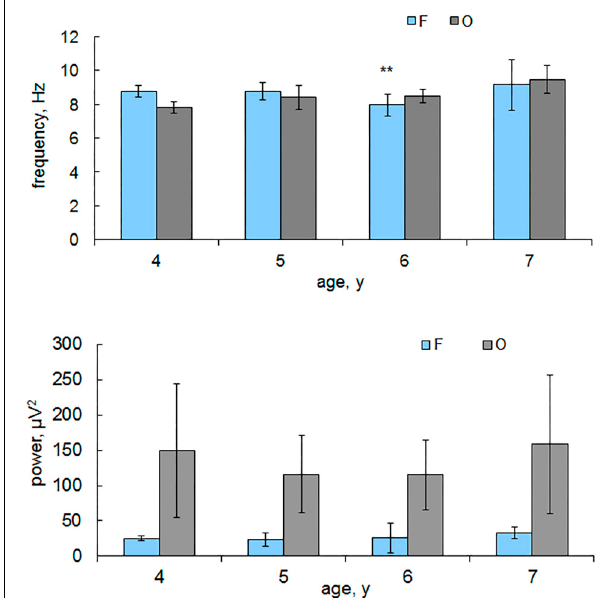
FIGURE 1 | The alpha peak frequency and power in the frontal and occipital areas depending on children’s age. Horizontal axis, the average age of children; vertical axis, the alpha frequency, Hz; power, µ V 2 . Blue columns, frontal areas (F); gray columns, occipital (O). Vertical lines are the standard error bars. ** indicates the age when the frequency values are minimal, Mann-Whitney